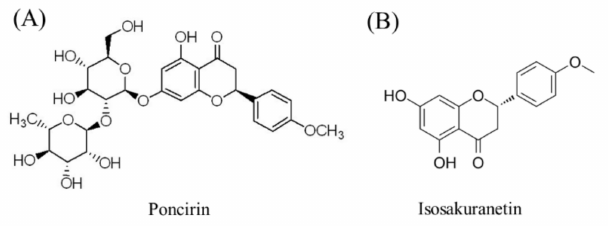
Figure 1. Chemical structure of poncirin ( A ) and isosakuranetin ( B